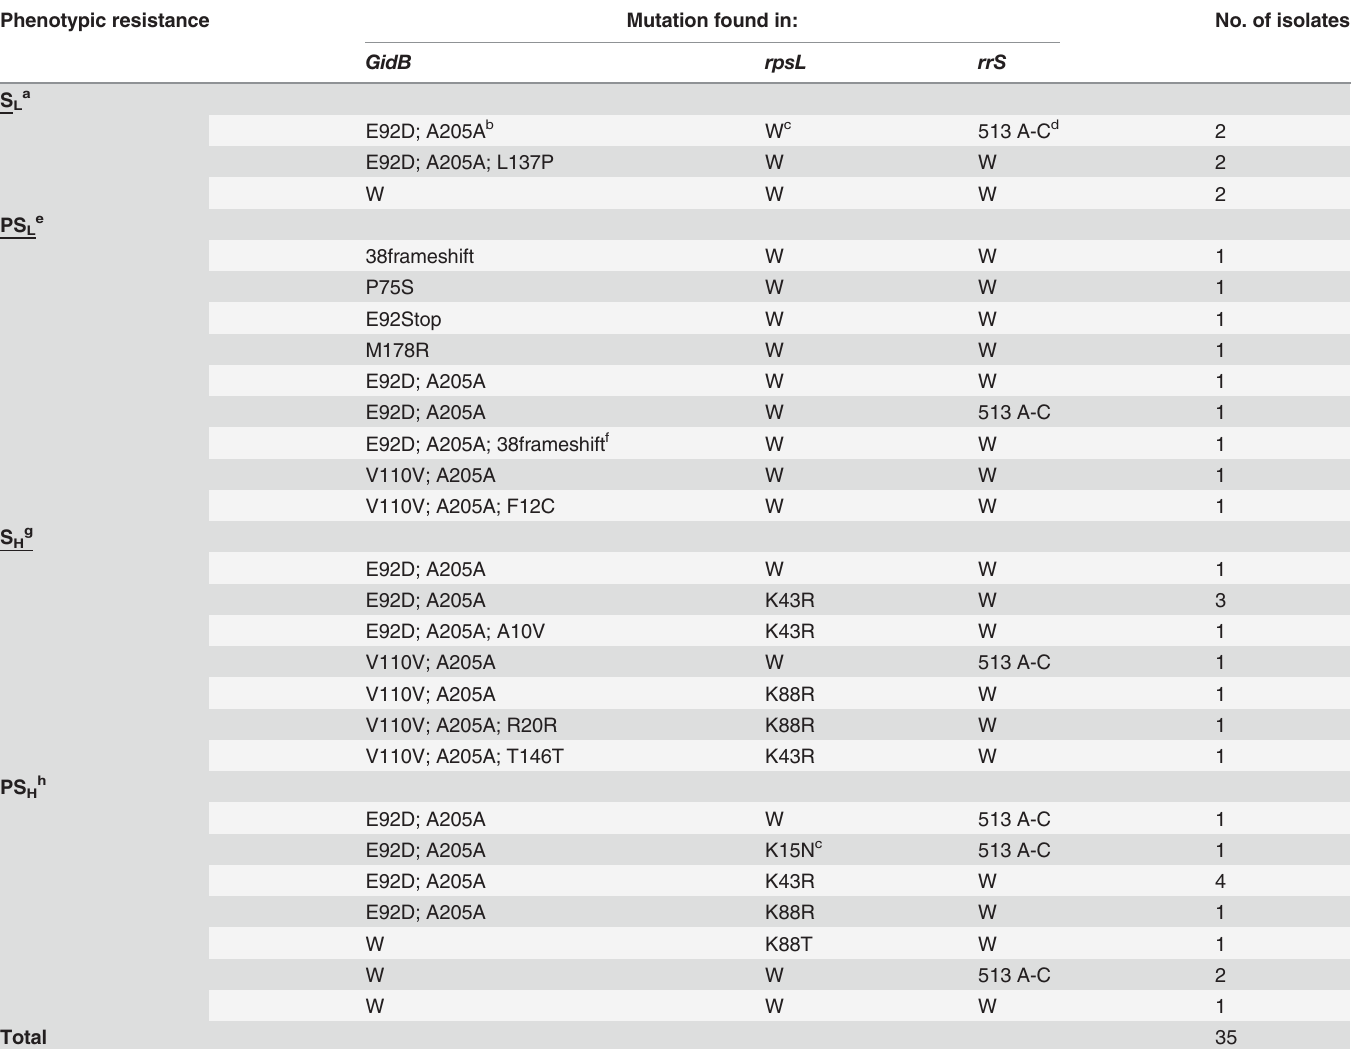
Table 3. Mutations in the gidB , rps L and rrs genes in streptomycin-resistant MTB strains. Phenotypic resistance Mutation found in: No. of